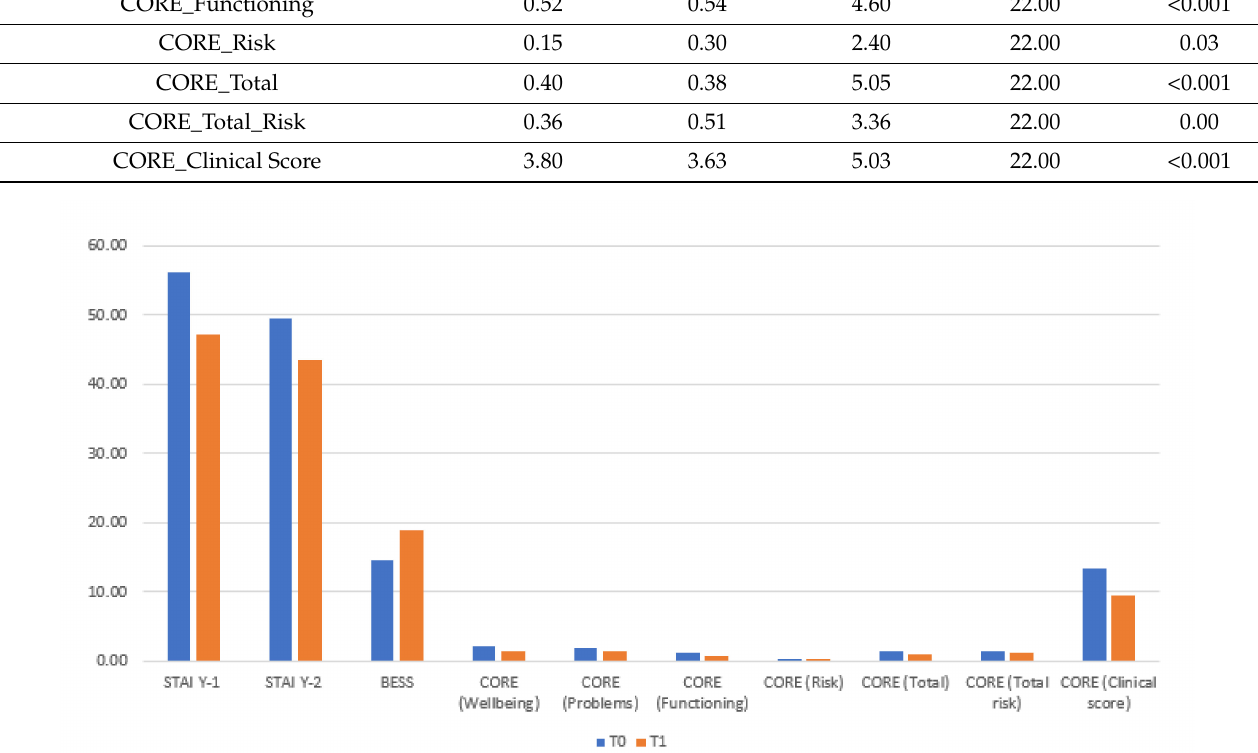
Figure 1. t -test with paired samples for T0 and T1: significant